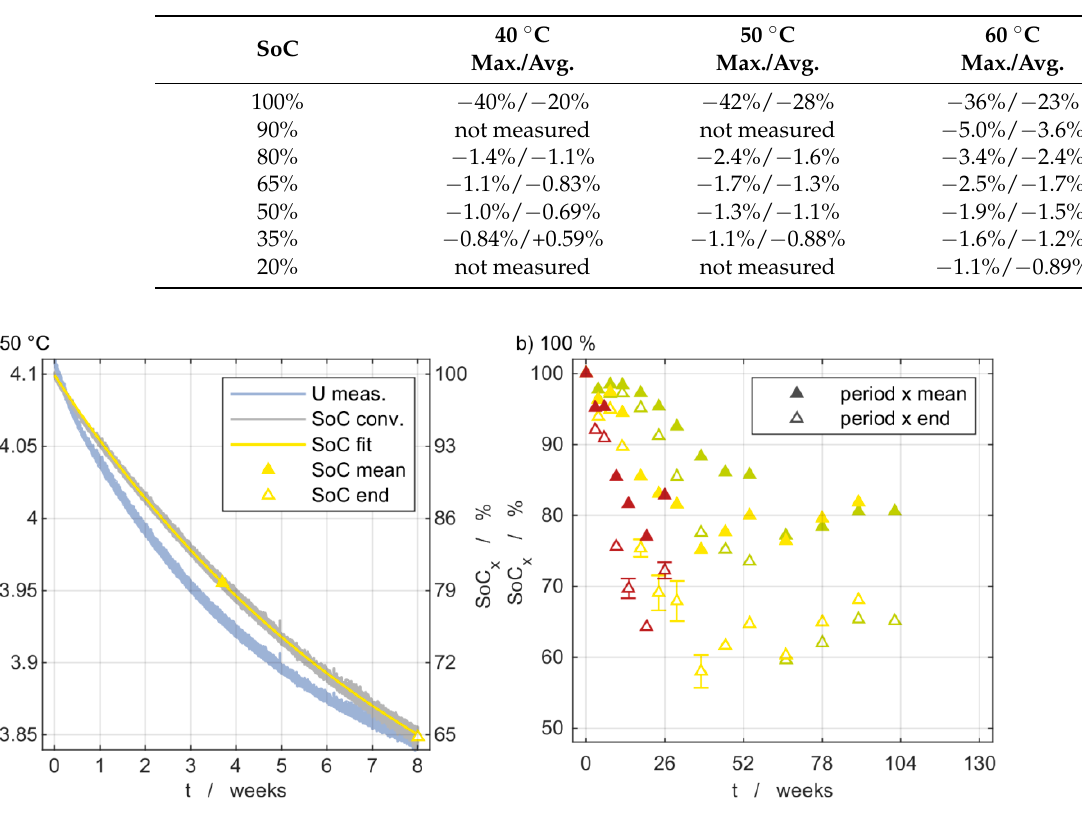
Figure 2. ( a ) Temporal development of the voltage (light gray) and the SoC (dark gray) and a fit of the SoC with the representative mean value of the SoC (yellow) during an exemplary aging period after 54 weeks at 50 °C with a significant self-discharge starting from 100% SoC. SoC end value based on Equation (1) used for fit validation and the derived SoC mean value as assigned storage SoC; ( b ) SoC decline caused by self-discharge during each aging period for cells initially stored at 100% SoC.